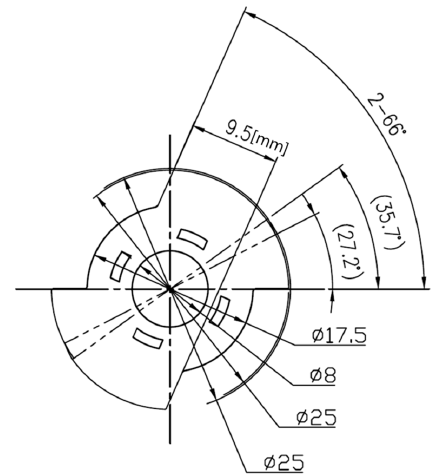
Figure 10. Cross section of the prototype rotor model.